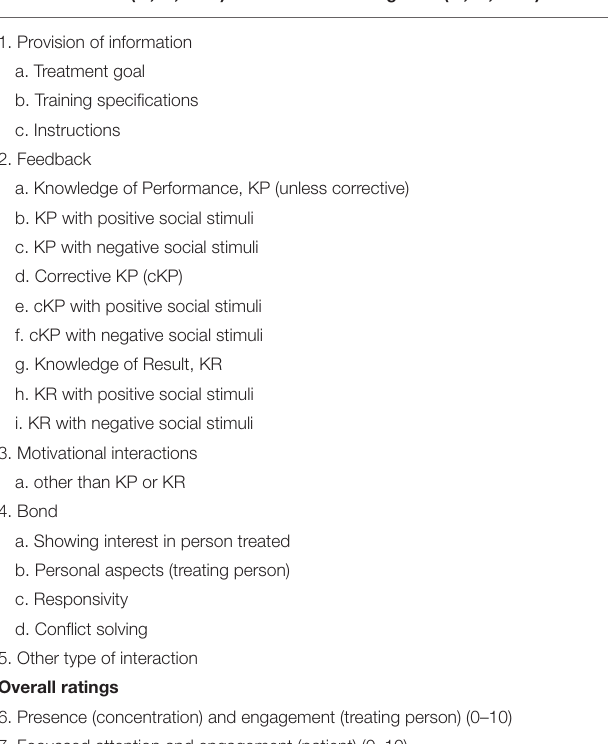
TABLE 1 | THER-I-ACT: observed thematic fields and aspects